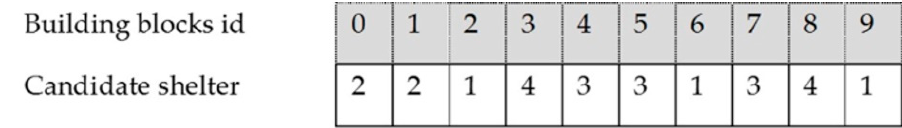
Figure 2. Main steps of the proposed Multi-Objective Artificial Bee Colony (MOABC) for evacuation planning.